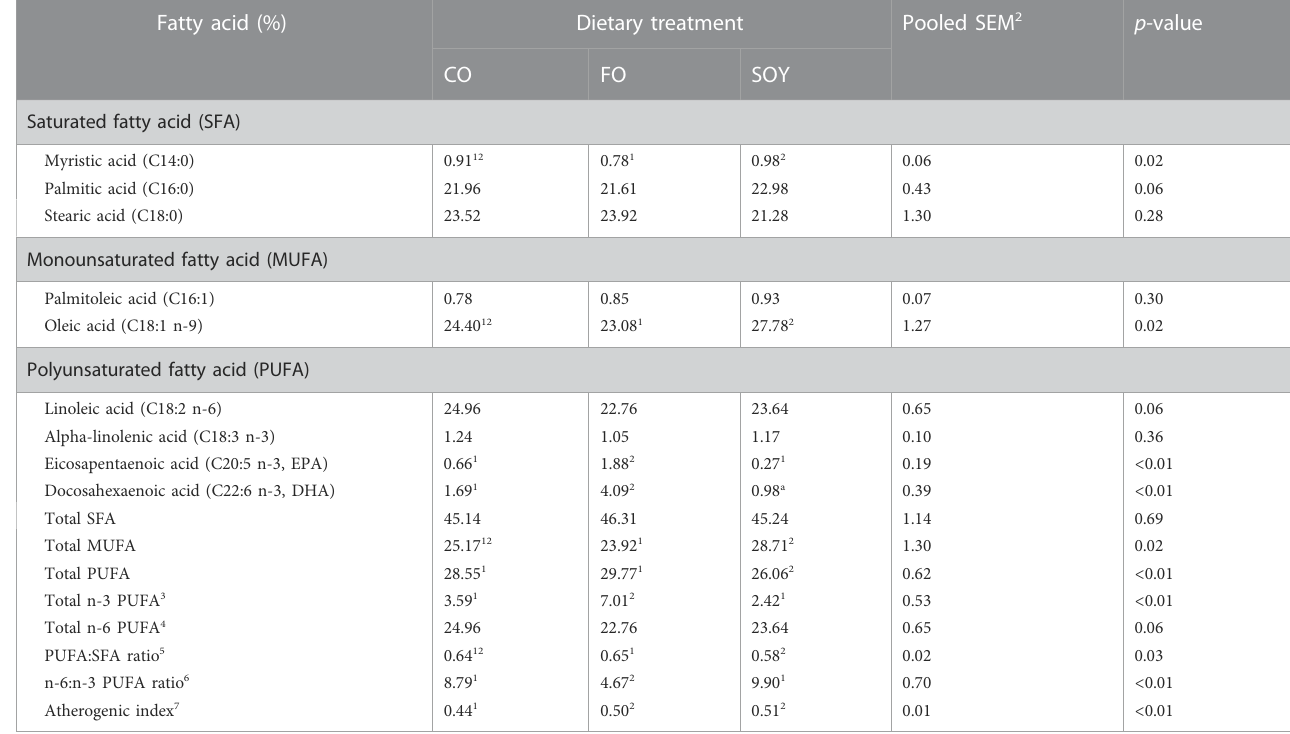
TABLE 1 Effects of dietary treatments on the fatty acid pro fi le deposited in the liver of male pigs. Fatty acid (%) Dietary